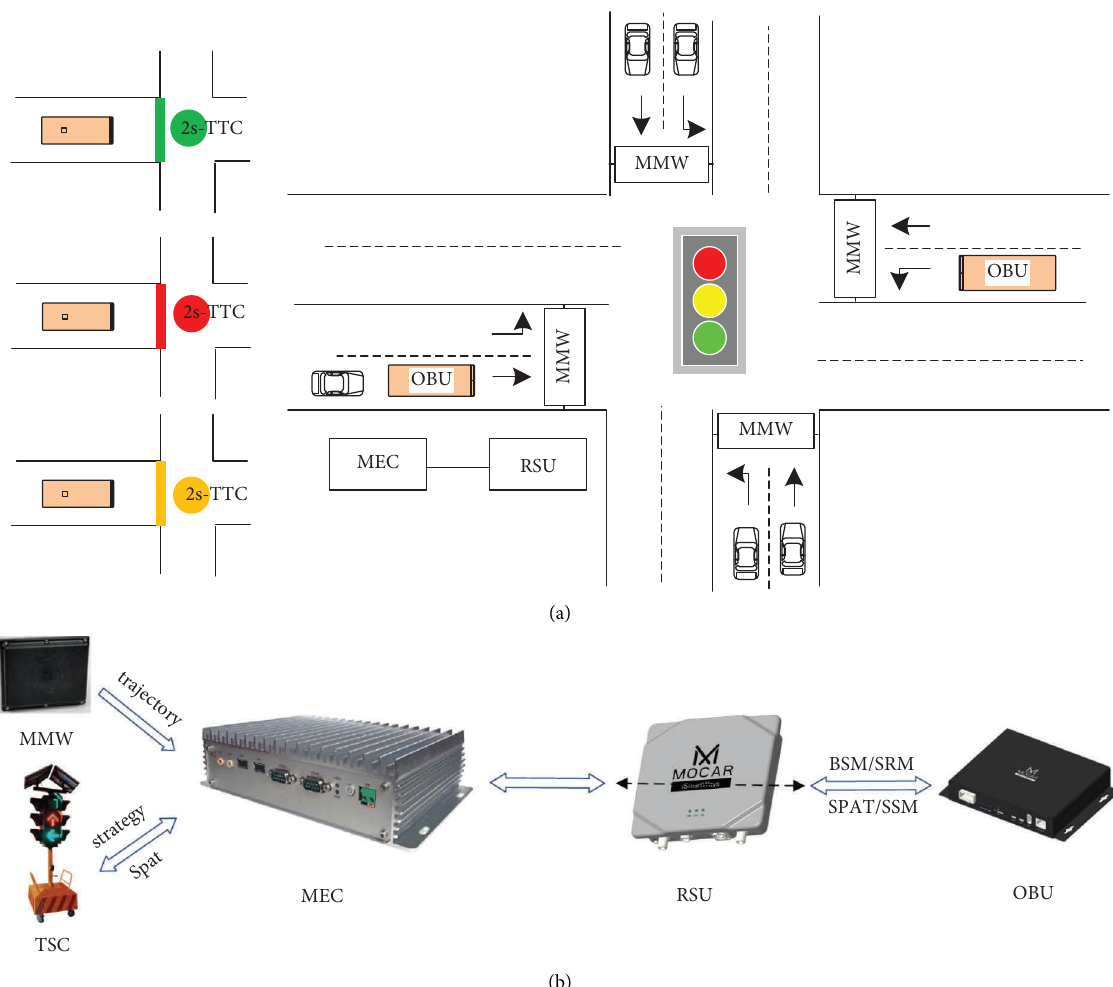
Figure 1: Problem defnition. (a) Multidirectional priority request resolution problem under mixed trafc conditions. (b) Information exchange